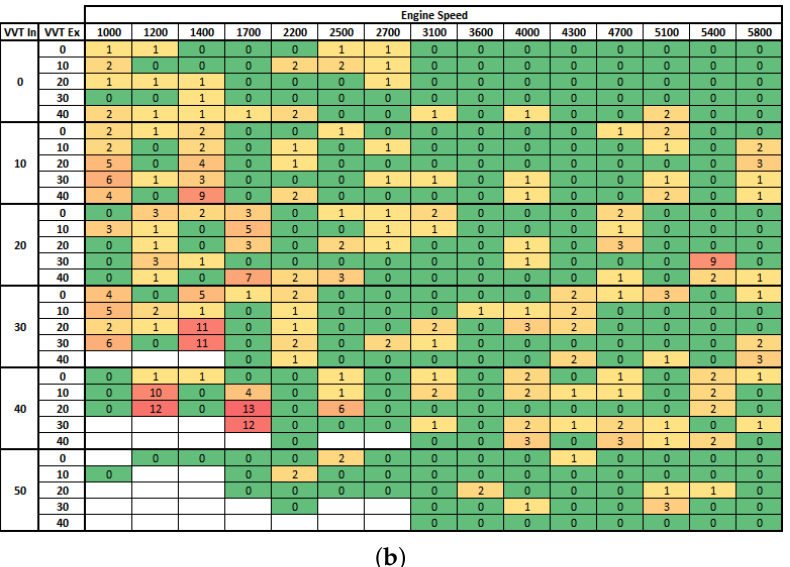
Figure A2. Distribution of points where the fuel injection mass prediction erro was higher than 3% ( a ) Levenberg–Marquardt backpropagation, ( b ) Bayesian regularization